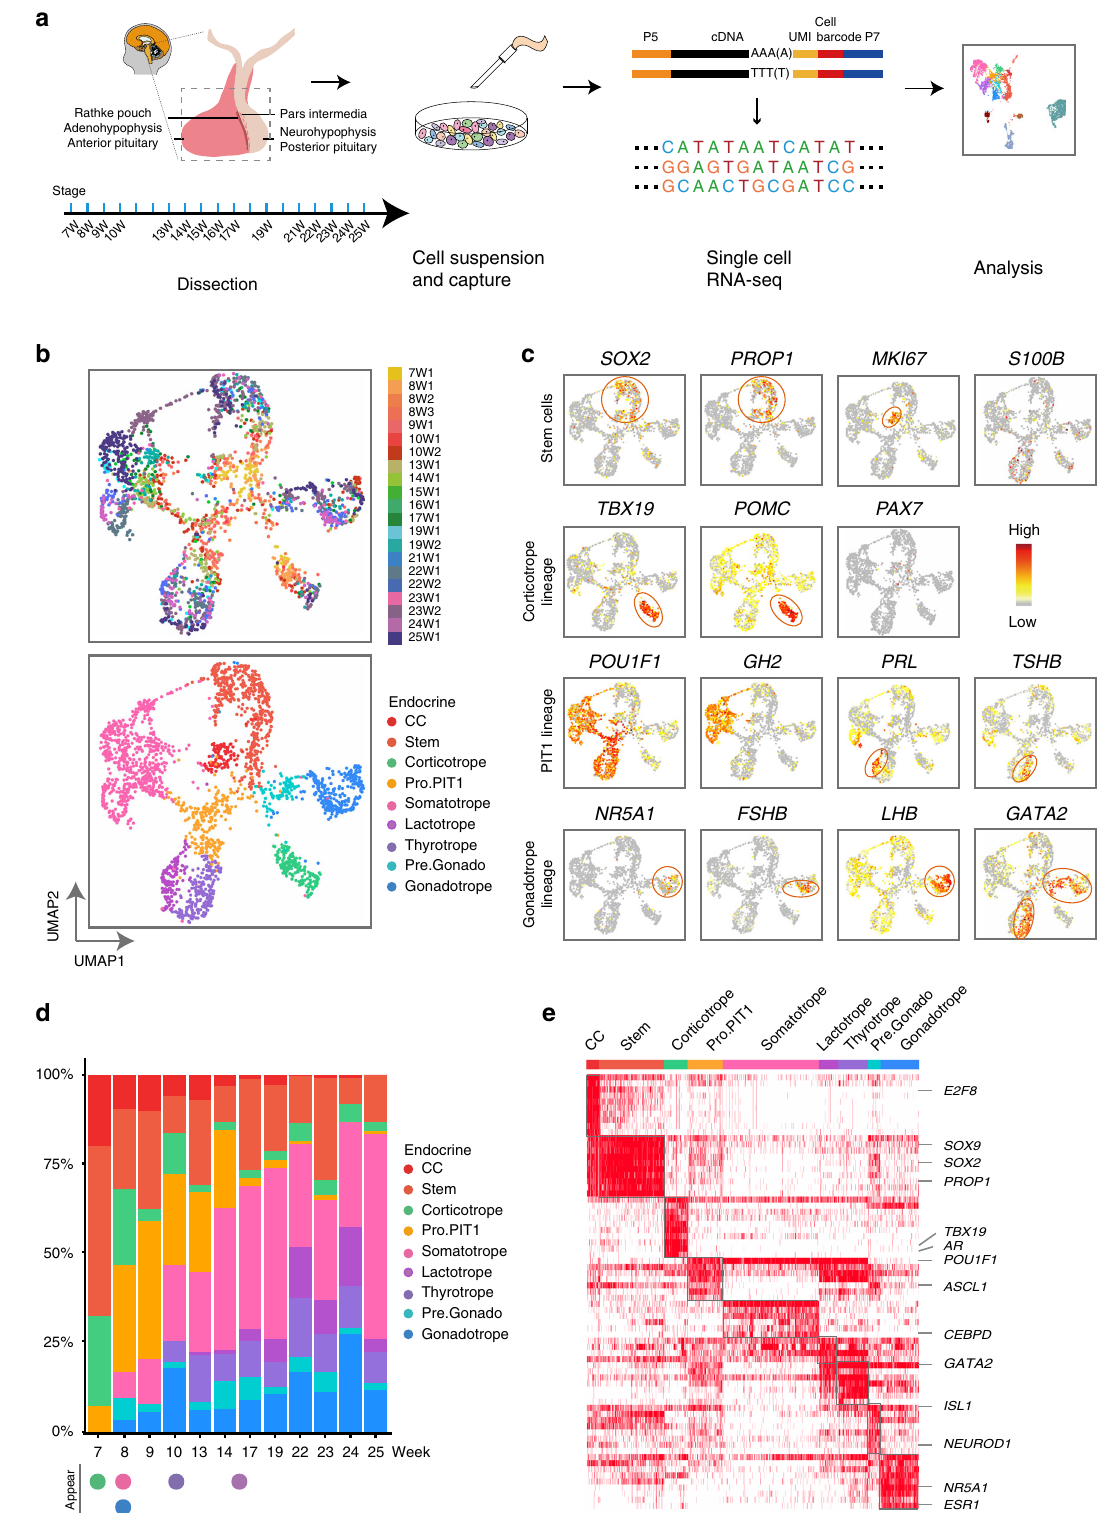
Fig. 1 Diversity of cell types in the human fetal pituitary. a Experimental fl owchart for the scRNA-seq analysis of the human fetal pituitary. b UMAP plots showing the clusters of the cell cycle cells (CC), stem cells, the progenitor cells of PIT1 lineage (Pro.PIT1) or precursor cells of gonadotrope (Pre.Gonado) and the terminal endocrine cells (lower), and distribution of the fetal samples (upper). Dots: single cells. c Scatterplots showing expression of known markers, including TFs and hormone genes, projecting on the UMAP plot (b). Gray to red indicates no expression to high expression levels. d Bar plots showing the proportions of each cell type in each stage. Solid circles at the bottom indicate the earliest stages when a hormone producing cell type appears. e Heatmap showing the activated TFs predicated by SCENIC. For each cell type, the top 10 -log(P value) speci fi c TFs being activated are shown, which ranked by number of cells. Columns are individual cells and rows are individual genes. White: not activated; red: activated. The expression levels of these TFs are shown in Supplementary Fig.